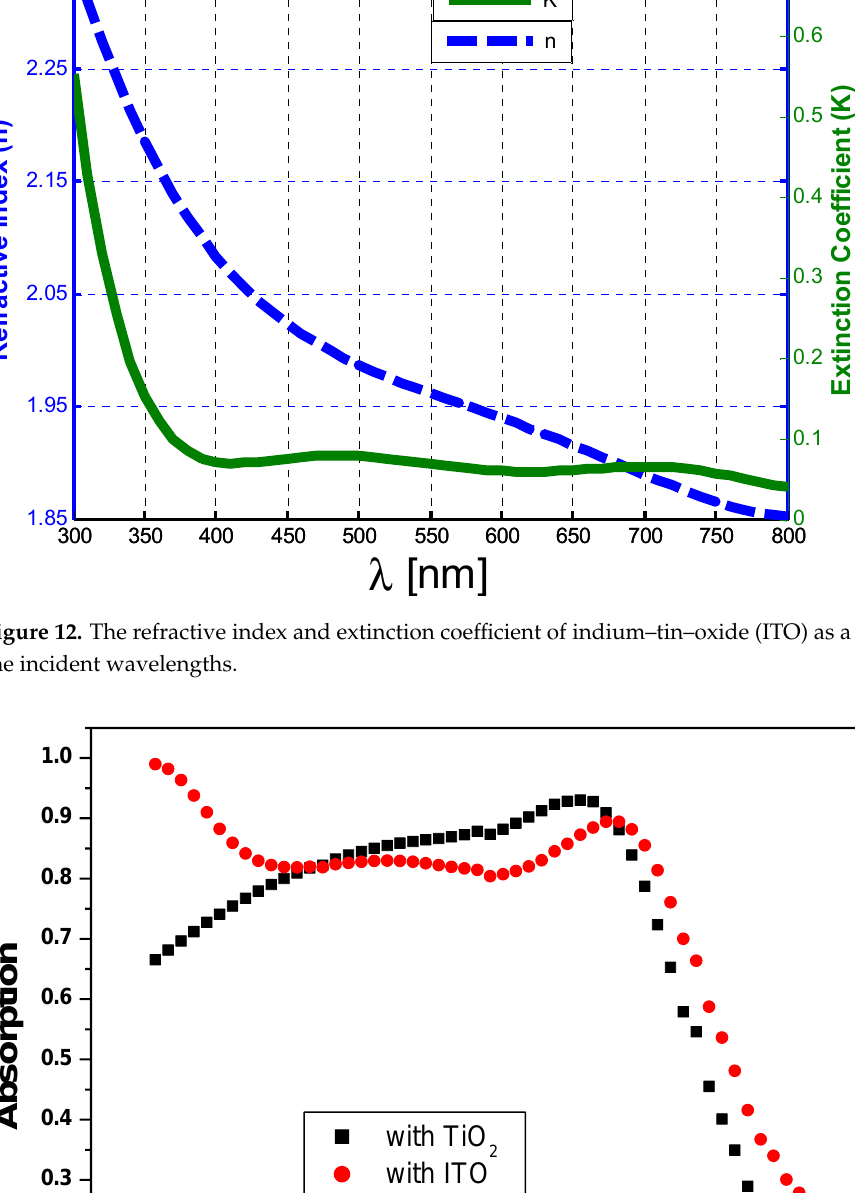
Figure 11. Schematic structure of an amorphous silicon solar cell with two electrodes.